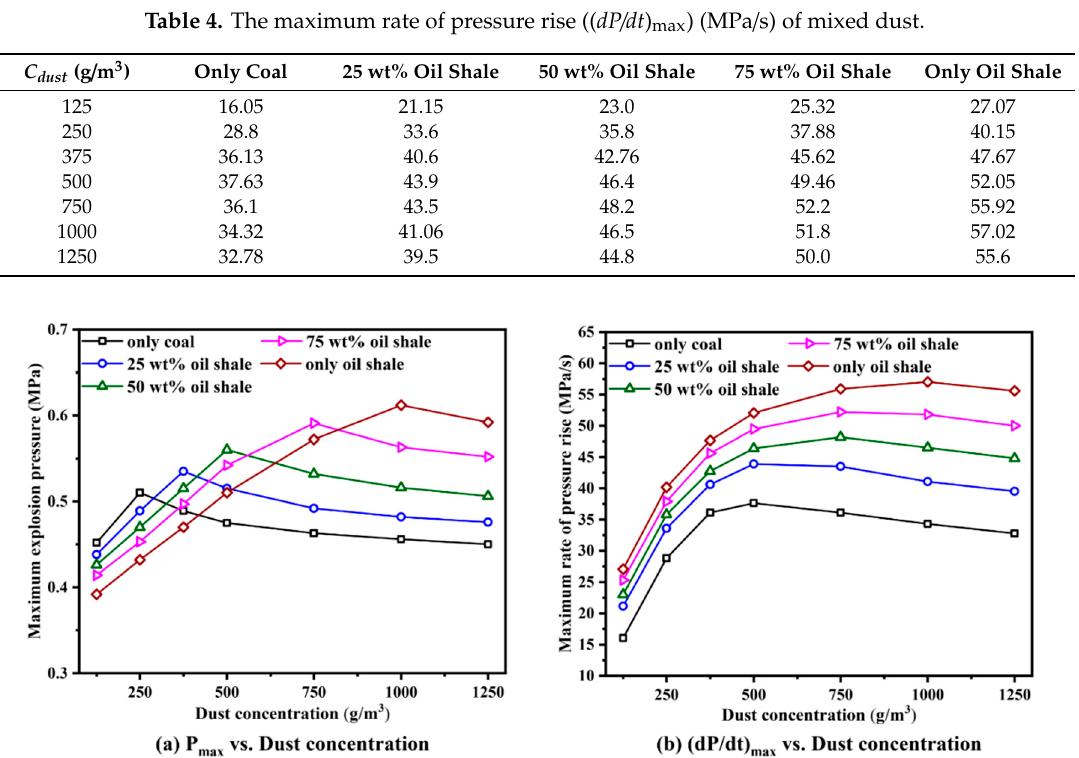
Figure 7. P max and ( dP / dt ) max of the dust cloud relative to dust concentration: ( a ) P max versus dust concentration; ( b ) ( dP / dt ) max versus dust concentration.